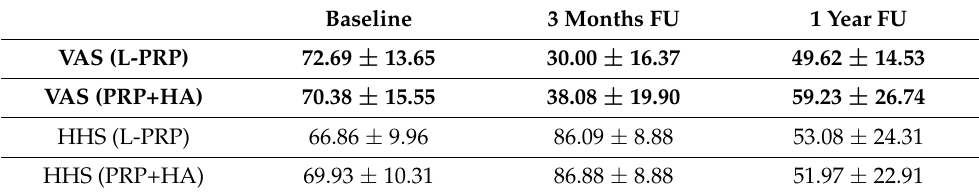
Table 2. Outcomes are reported with mean ± standard deviation (M ± SD). Results showing significant changes (by repeated measures ANCOVA, adjusted for age) are reported in bold characters ( p < 0.05). FU = follow-up.